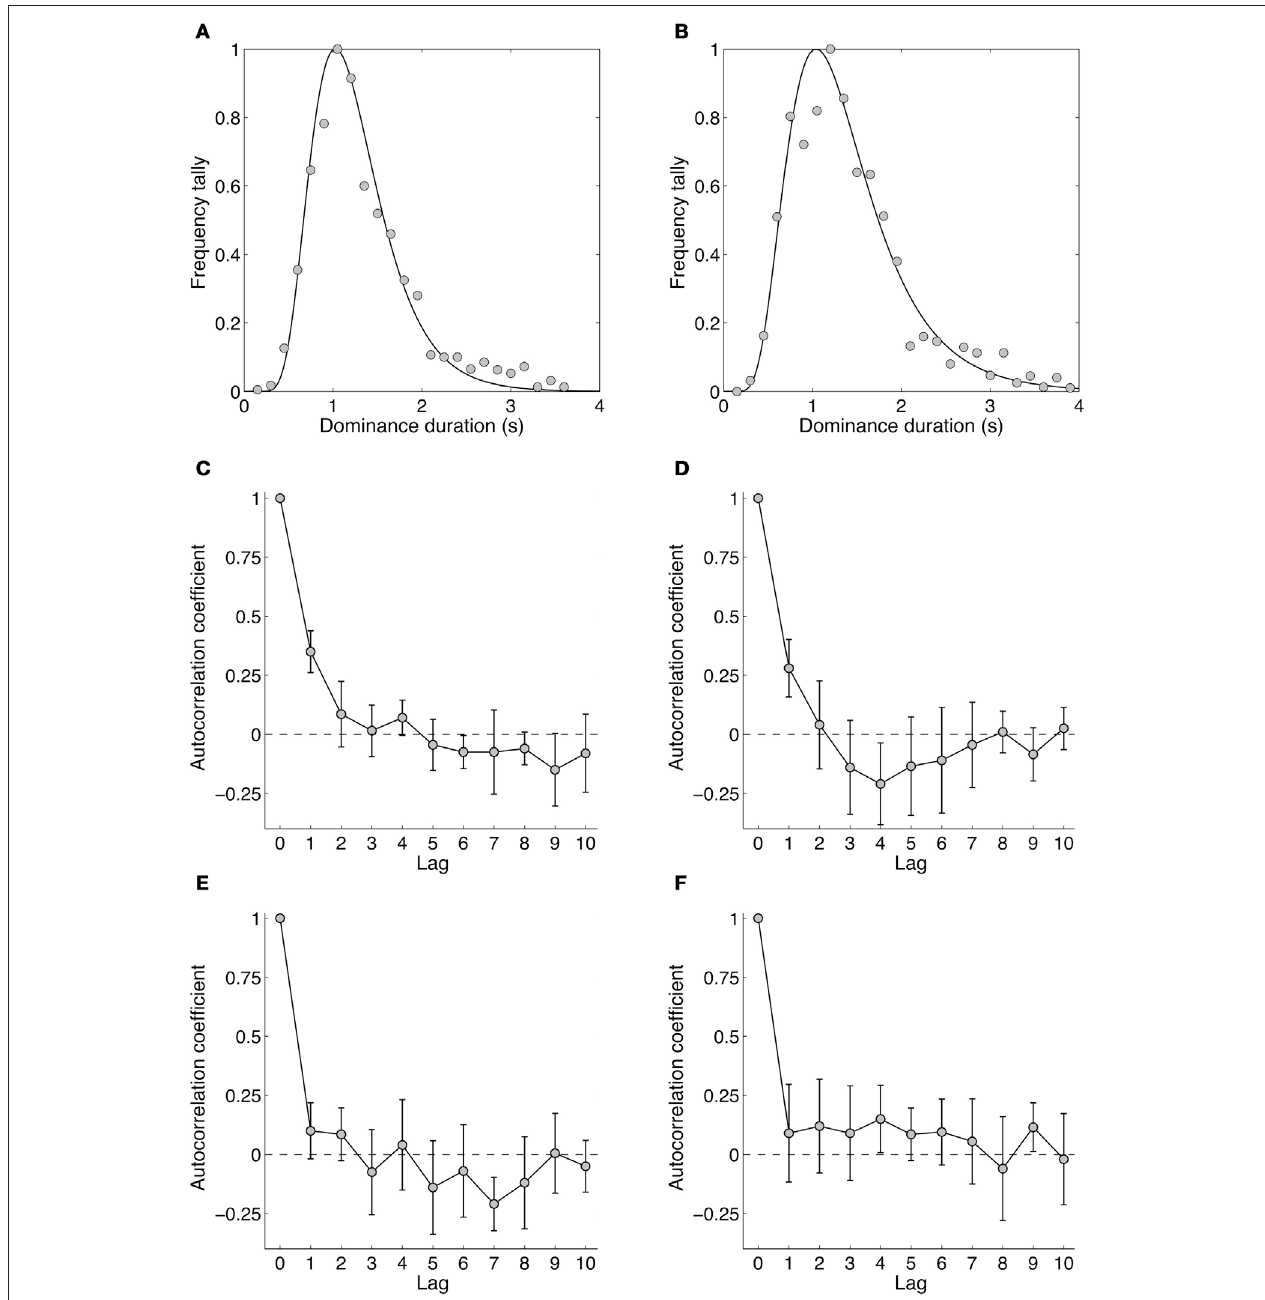
FIGURE 7 | Data from Experiment 4 showing the dynamics of binocular rivalry between stimuli differing by four octaves (1.18 and 18.93Hz). (A,B) Data from two individual observers (authors David Alais and Amanda Parker) showing distributions of dominance times obtained from 10 one-minute rivalry trials. Data were binned into 150ms epochs and the